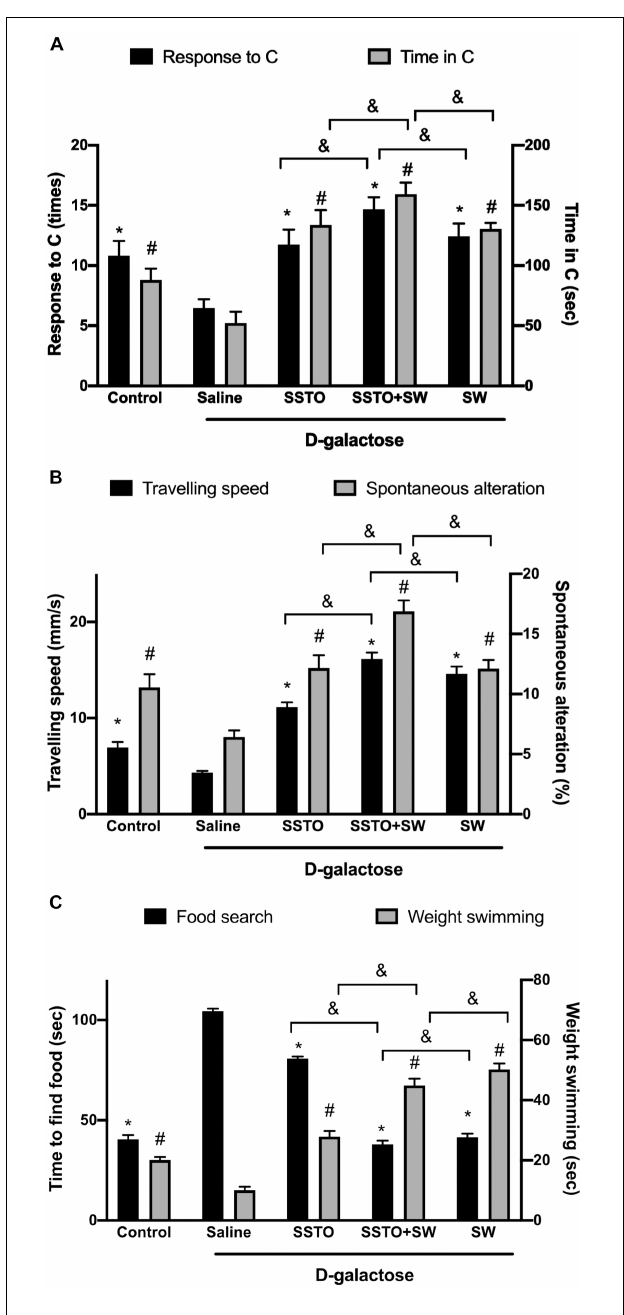
FIGURE 3 | Effects of SSTO and swimming training on aging rats. (A) Exploration evaluation. The left y -axis (black bars) shows the number of times that the rats entered the new environment (arm C) within 10 min, and the right y -axis (white bars) shows the average duration for which the animals stayed in arm C. (B) Mobility determination. The left y -axis (black bars) shows the traveling speed, and the right y-axis (white bars) indicates the spatial learning ability, as evaluated by the spontaneous alteration percentage. (C) SSTO and swimming training improved short-term spatial memory (black bars) and physical performance (white bars). Left y -axis: average time to find food; right y -axis: endurance measured as weight-loaded forced swimming duration. * # Statistically significant difference as compared with the aged rats with saline treatment; & statistically significant difference when compared with SSTO + swimming group.